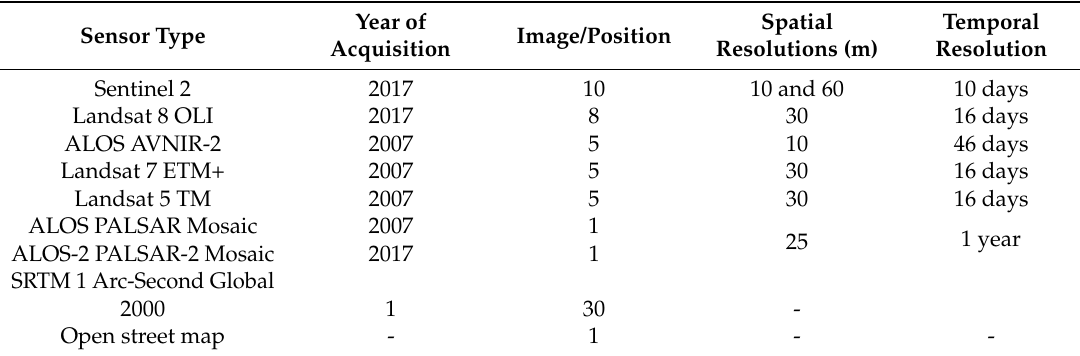
Table 2. Dataset organization, layer composition for each sensor type in each dataset, and the total number of images for each